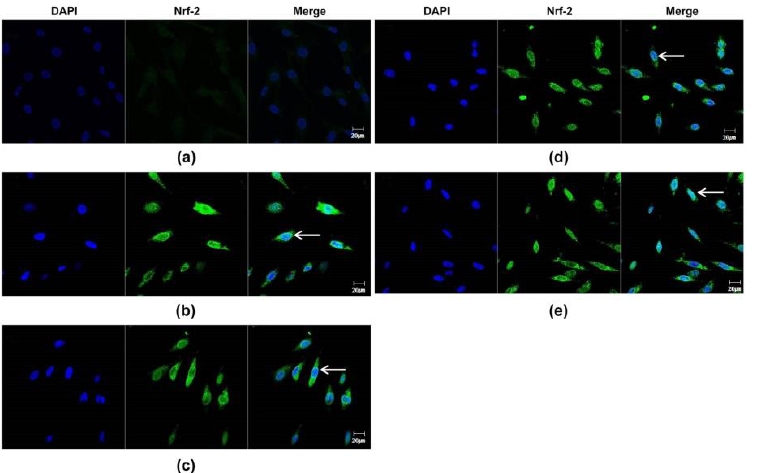
Figure 3. Confocal microscopic detection of Nrf-2-positive fluorescence in plant essential oils-treated DPC. ( a ) Nrf2-positive fluorescence signals from non-treated DPCs (control). ( b ) Nrf2-positive fluorescence signals from lavender-treated DPCs. ( c ) Nrf2-positive fluorescence signals from lemongrass-treated DPCs. ( d ) Nrf2-positive fluorescence signals from rosemary-treated DPCs. ( e ) Nrf2-positive fluorescence signals from chamomile-treated DPCs. The arrow represents nuclear translocation of Nrf2. Scale bar: 20 μm .